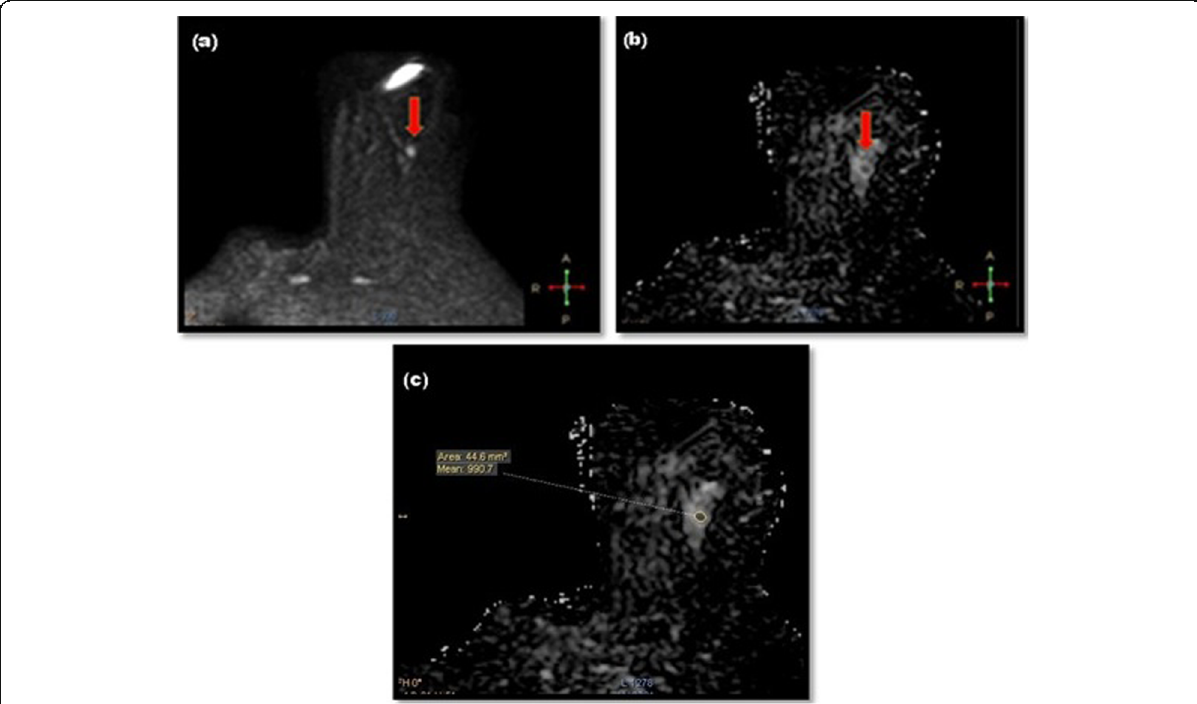
Fig. 2 DWIs analysis. a DWI at b 1500, b ADC map, c ADC value of 0.99 × 10 − 3 mm 2 /s. The left breast deep central mass showed restricted diffusion of persistent bright SI on DWI and intermediate SI on ADC map with an estimated ADC value of 0.99 × 10 − 3 mm 2 /s. Pathology and immunohistopathology revealed invasive duct carcinoma, grade I, negative for ER, PR and HER2 receptors